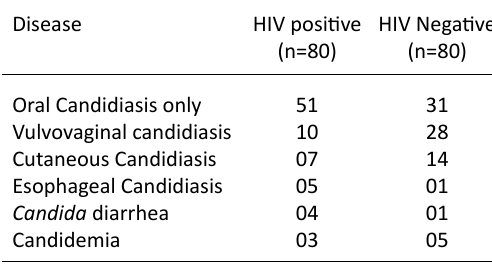
Table 2. Risk profile (mode of transmission of H.I.V.